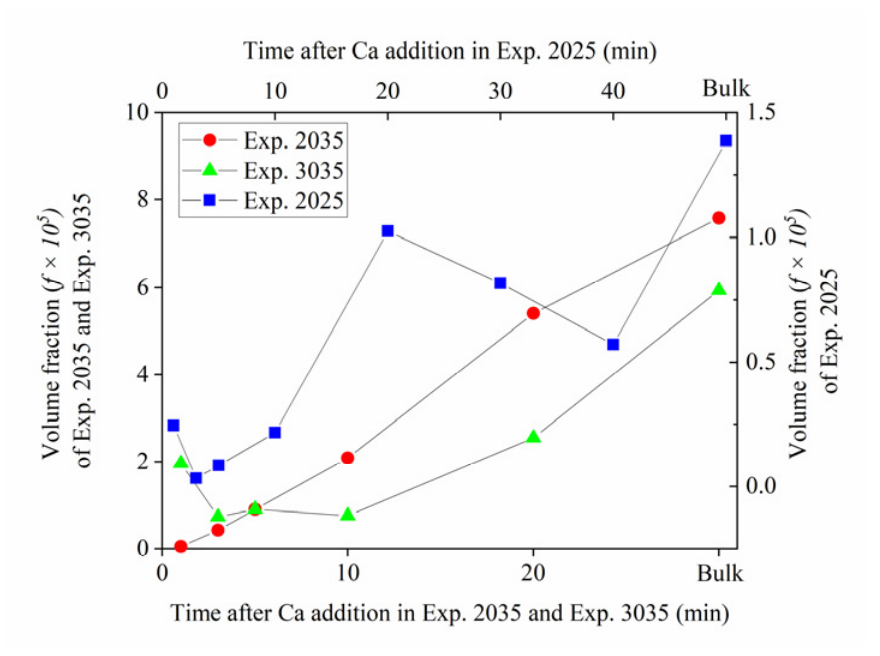
Figure 12. Variation in the volume fraction of CaS inclusions over time in Exp. 2035, Exp. 3035, and Exp. 2025.